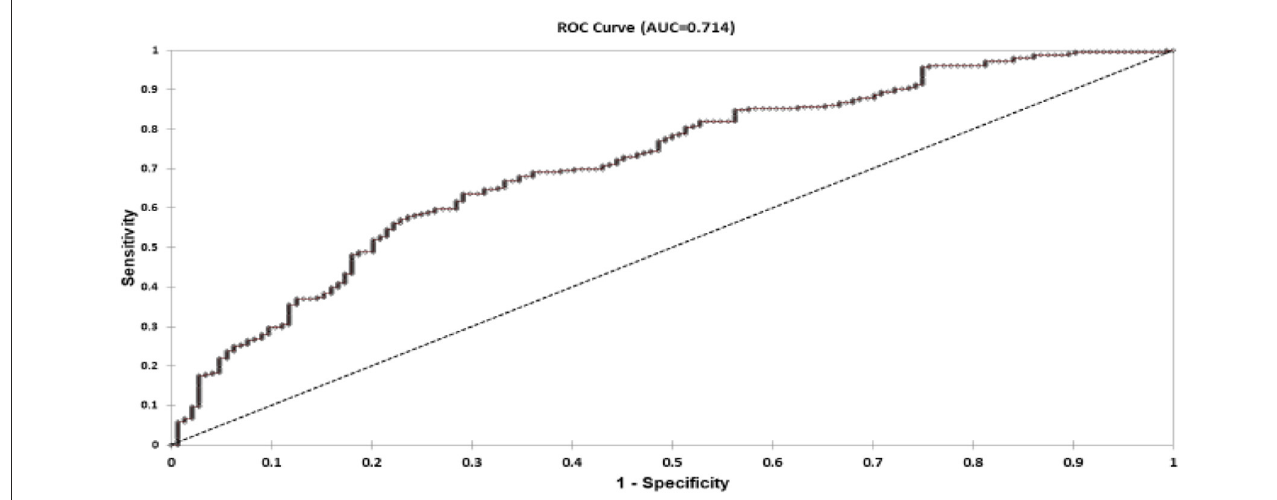
FIGURE3 Receiver operating characteristic (ROC)